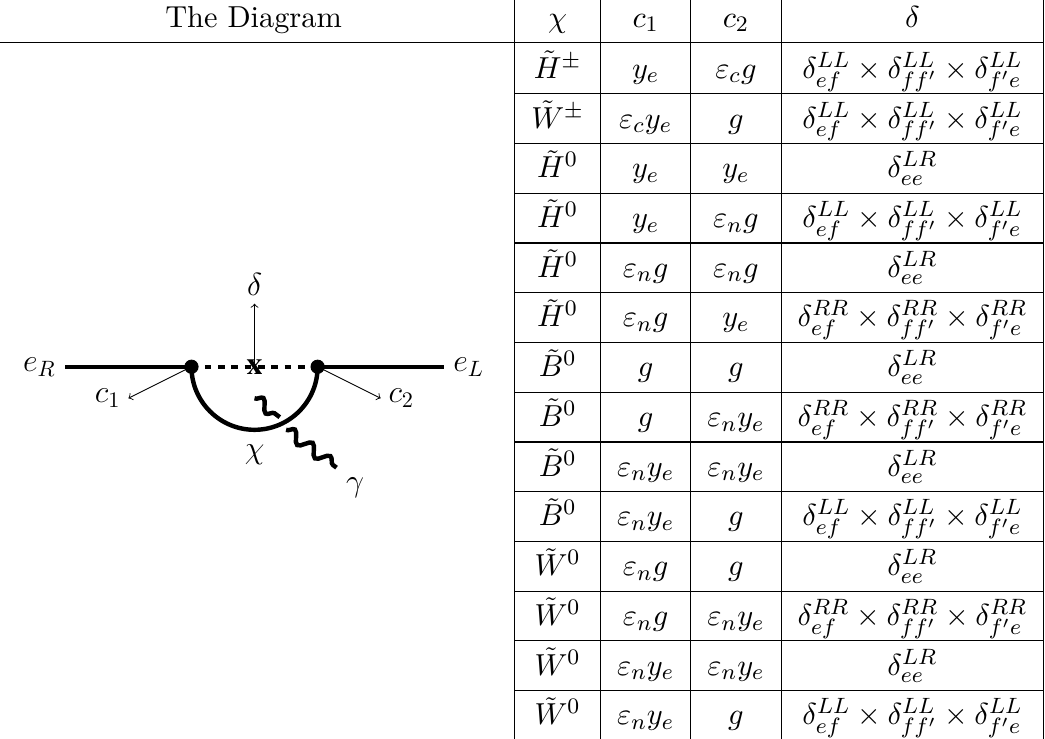
Table 3 . Diagrams with sleptons and gauginos/higgsinos in the loop contributing to the imaginary part of c R . This Wilson coefficient contributes to the eEDM. The general topology of the diagram 11 is shown on left. The second column shows the gaugino or the higgsino in the loop. The SM couplings appearing in each vertex, as well as ε s that characterize neutralino or chargino mixings, are shown in the next two columns. We consider all possible combinations of couplings with all possible fermions and sleptons in the loop. The last column includes the δ insertions on the slepton propagator. We are only including diagrams with the fewest number of δ insertions and at most one δ LR entry. These δ insertions are the source of CPV in our setup. As evident from the table, when ˜ m is not too large, i.e. δ LR is not too small, the diagram with a Bino in the loop and a chirality flip on the propagator dominates, while other diagrams have more suppression thanks to fermion mixings ε or the SM n/c